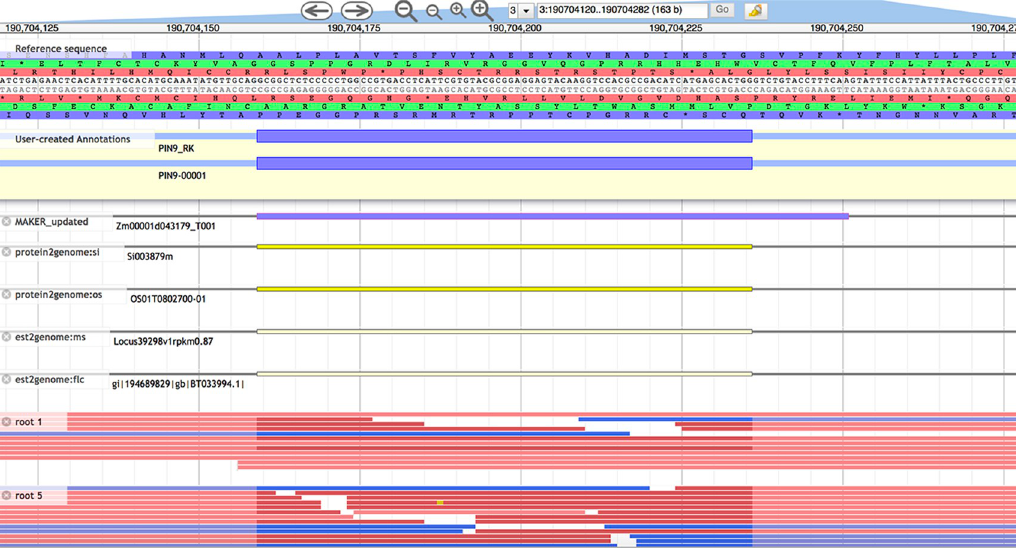
Fig 1. Curation of exon 3 of PIN9 (Zm00001d043179). Exons of incorrect length were the most common error detected by both triage methods. The Apollo editing window shows a “User-created annotation” at top followed by the longer, incorrect B73 RefGen_V4 model (“MAKER_updated”). The shortened exon was supported by aligned evidence: protein sequences from sorghum and rice, assembled long Iso-Seq reads combined from six tissues, and RNA-seq from roots, among other tissues.